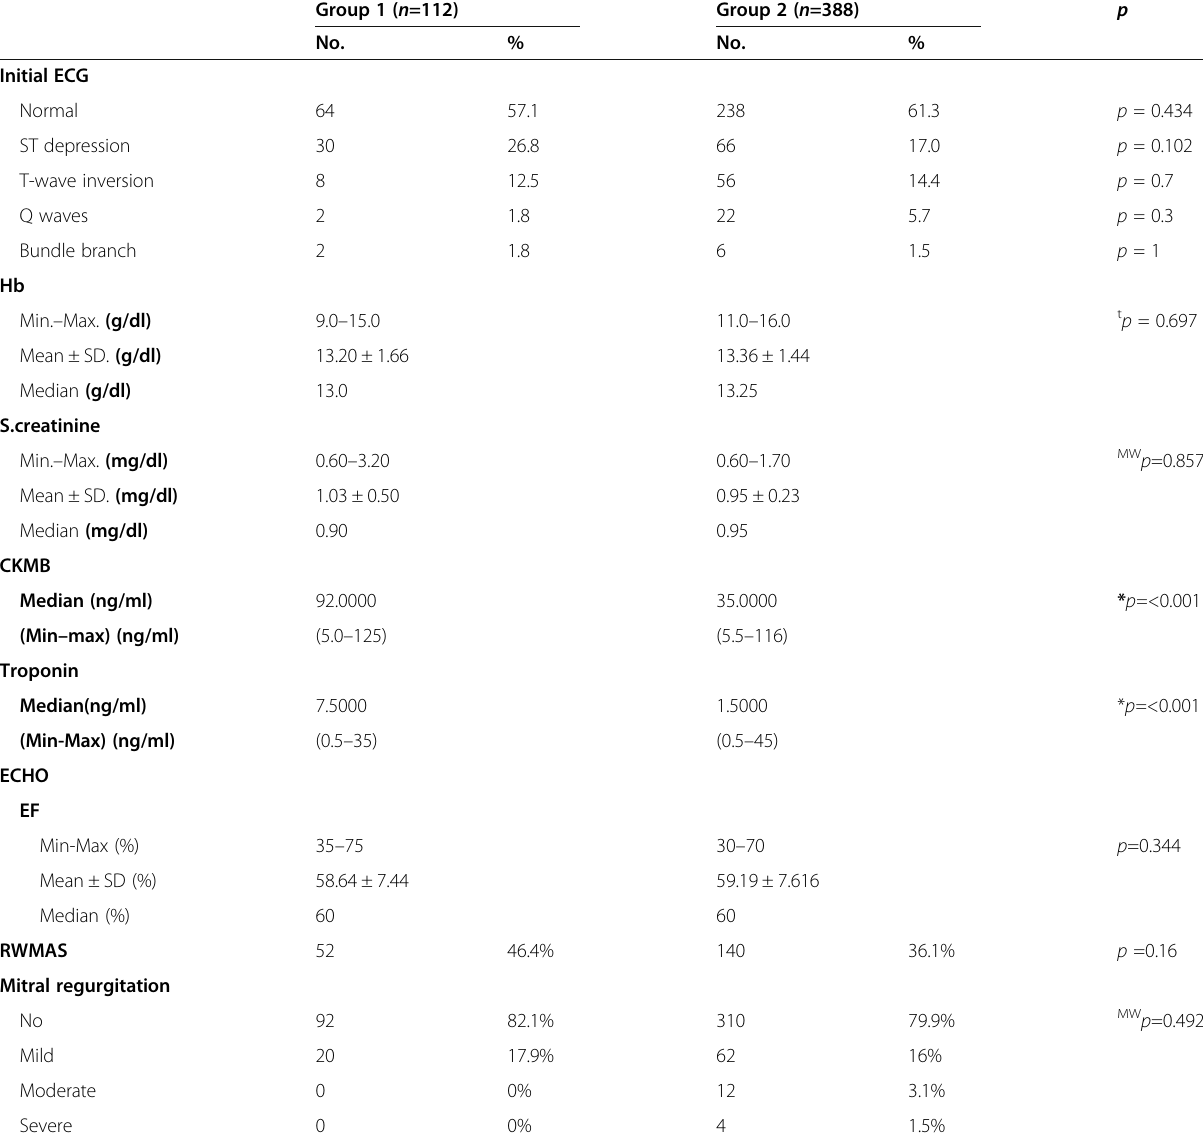
Table 2 Baseline ECG, echocardiography, and laboratory results of both groups Group 1 ( n =112) Group 2 ( n =388) p No. %